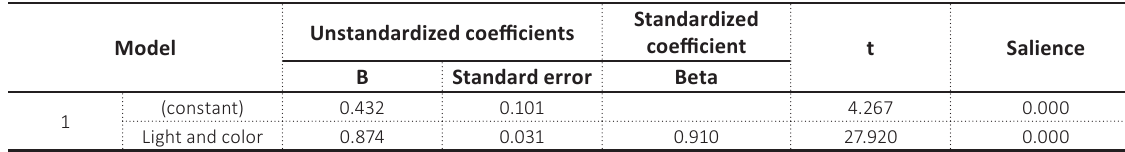
Table 7. Linear regression coefficients of the relationship between light and color and consumers’ purchase intention